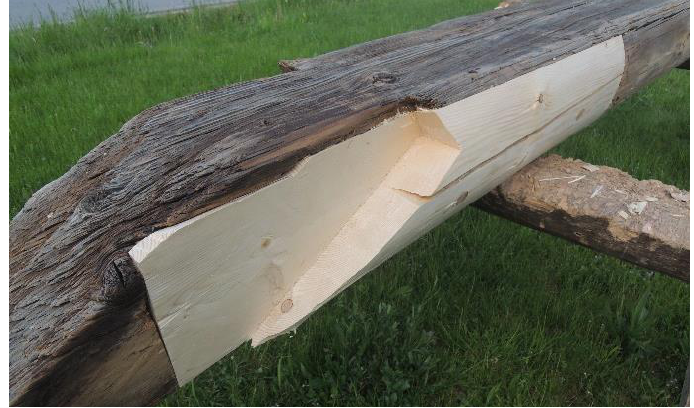
Figure 31. Dovetail joint of the damaged timber beam (I2) after the repair.